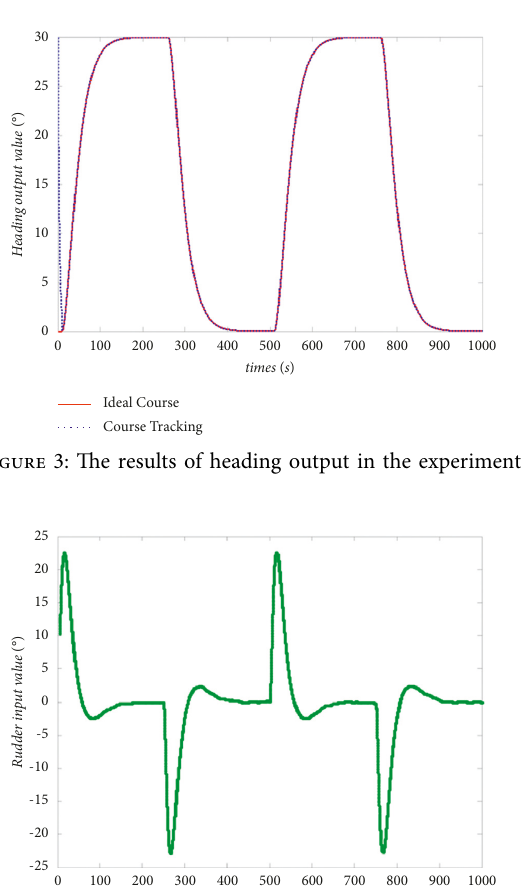
Figure 2: The process of parameter optimization of the course tracking controller for USV.